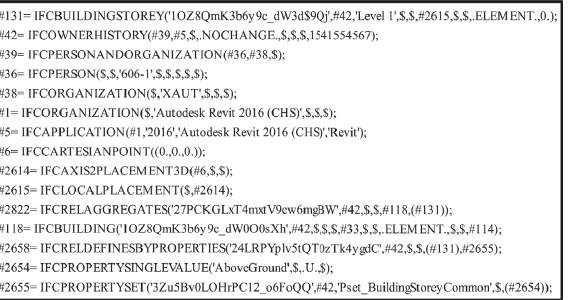
Figure 5: Partial fragments of the IFC